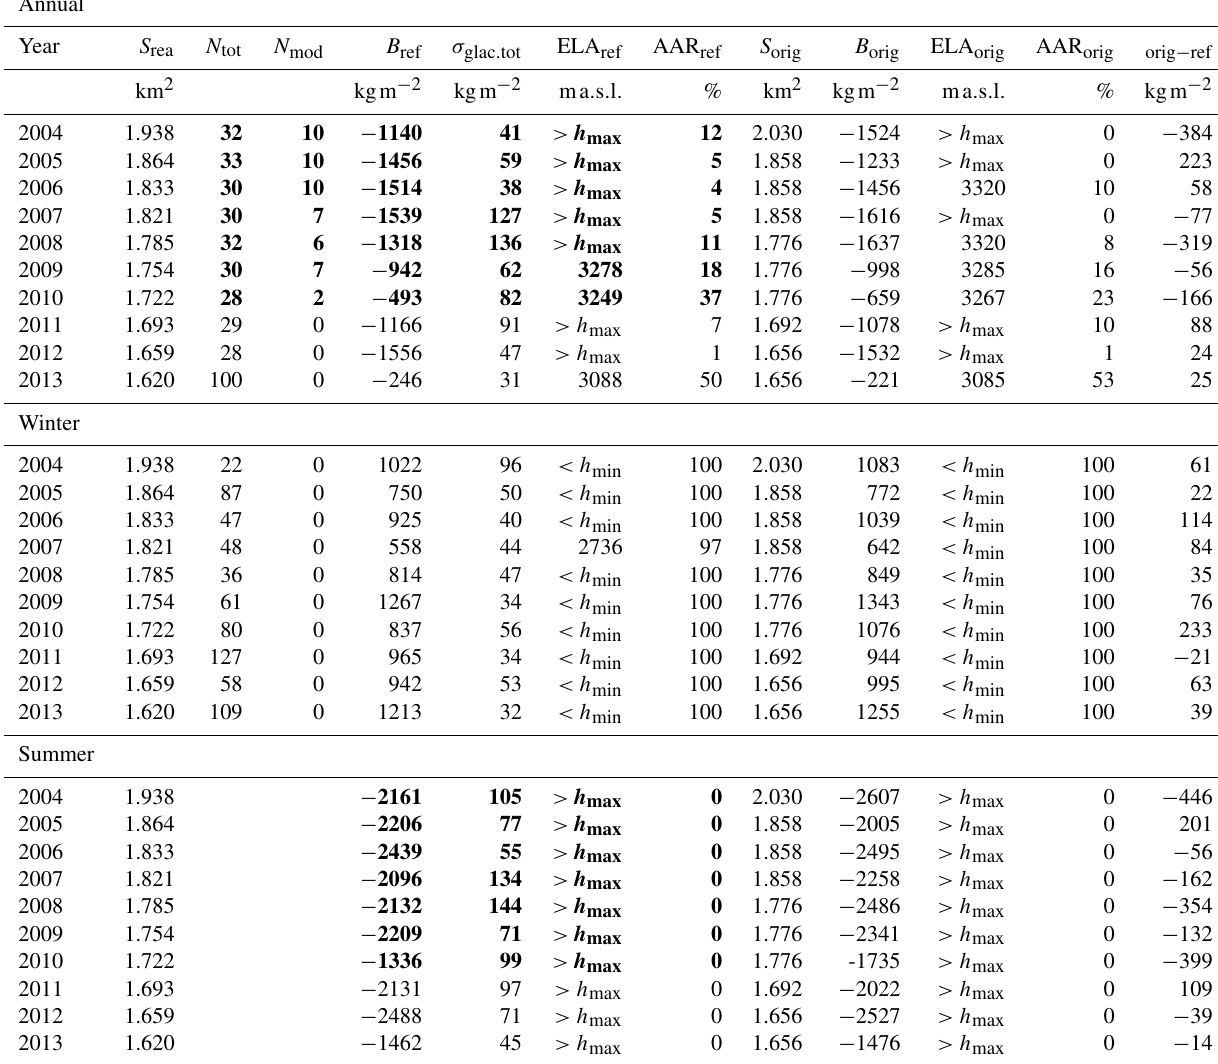
Table 1. Reanalyzed and original annual and seasonal mass balances and corresponding glaciological key numbers for Langenferner. S rea stands for the glacier area used in the reanalysis, N tot is the total number of point mass balances used for glacier-wide reanalysis calculations, N mod is the number of modeled point balances, B ref is the resulting glacier-wide specific balance, σ glac . tot is the total random error and ELA ref and AAR ref are the reanalyzed ELA and AAR. S orig is the glacier area used in the original series, B orig is the original glacier-wide specific balance, ELA orig and AAR orig are the original ELA and AAR and orig − ref refers to the difference between original and reanalyzed record. Bold entries refer to results which are influenced by mass balance